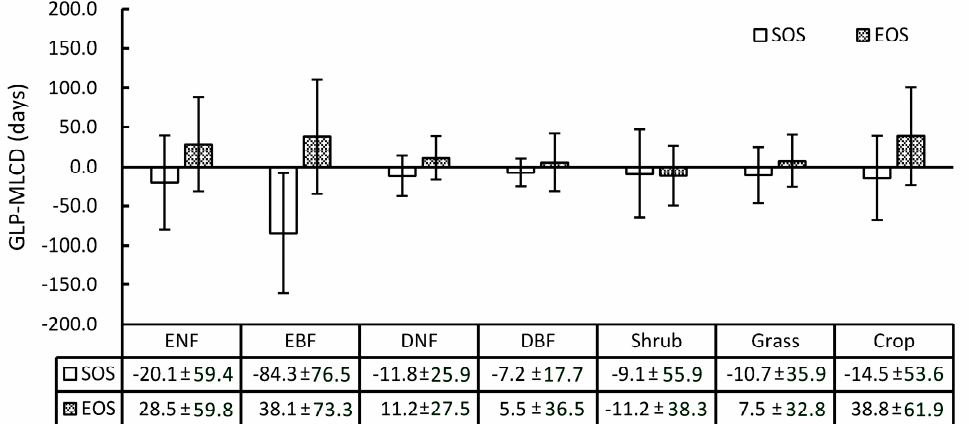
Figure 7. The means and standard deviations of the difference values between the GLP and the MLCD in different vegetation types.